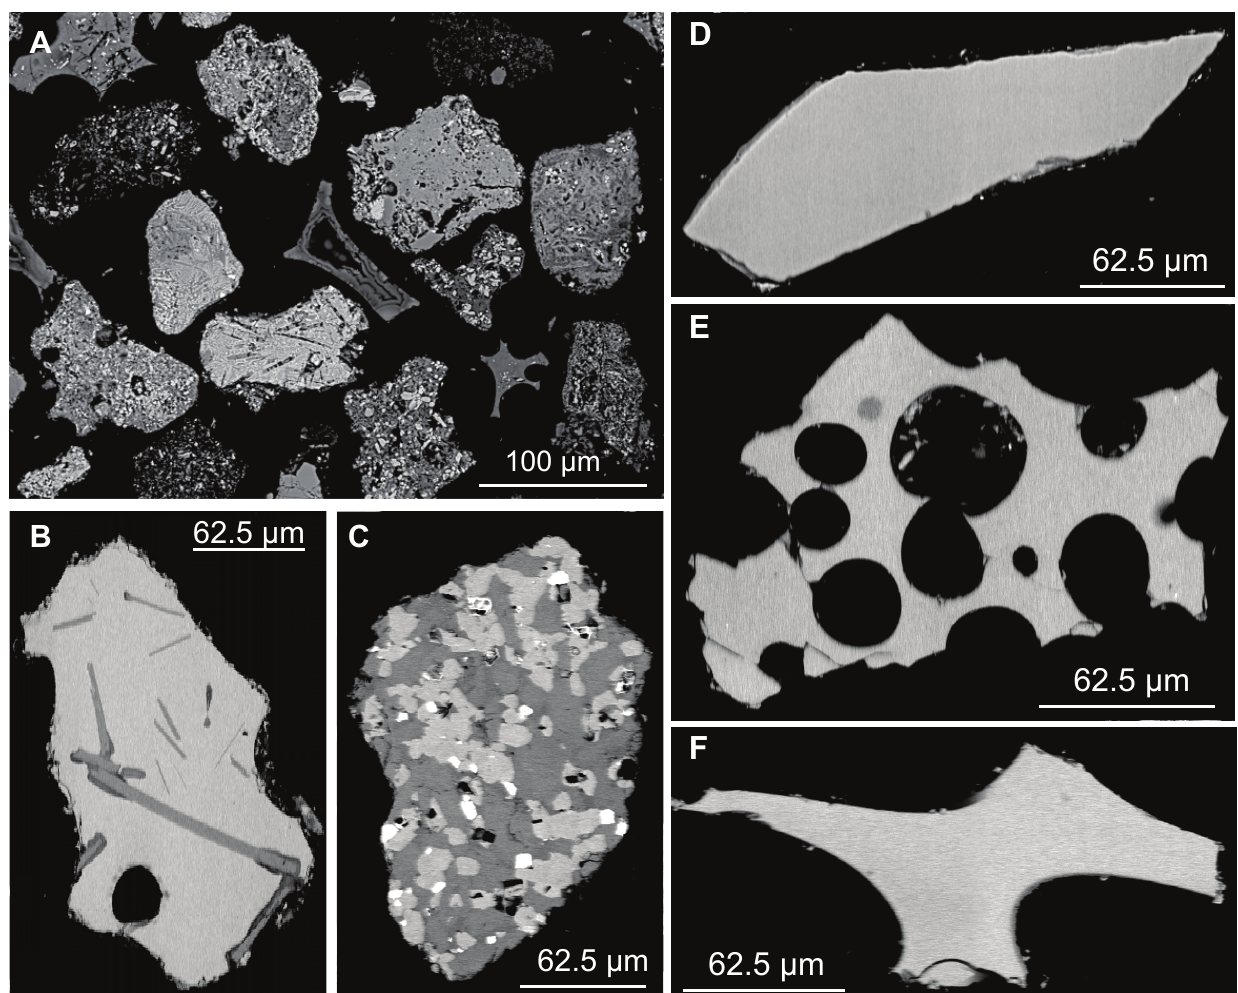
Figure 6: To the left, three examples of types of grains excluded from shape analysis in Figure 10. [A] Al- tered/devitrified glass from Ash ´ 13. [B] Grain with microlites (Ash ` 46). [C] Lithic grain (Ash ` 36). To the right is shown an example of each type of glass texture. [D] Dense glass (Ash ` 1): blocky, poorly vesicular, [E] Vesicular glass: >20 % vesicularity, and [F] Shard (Ash `